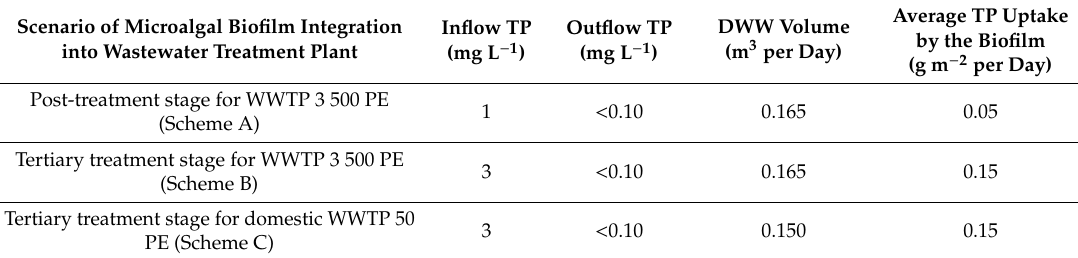
Table 1. Summary of parameters used for calculating area requirements: the initial total P concentrations (Inflow TP) in the influent to the microalgal biofilm system, total P concentration (Outflow TP) in the e ffl uent subsequent to treatment using a microalgal biofilm, daily wastewater volume (DWW volume) per person equivalent (PE) and TP uptake rates by the biofilm obtained for the quoted inflow TP concentrations (schemes A, B, and C; Figure 2).